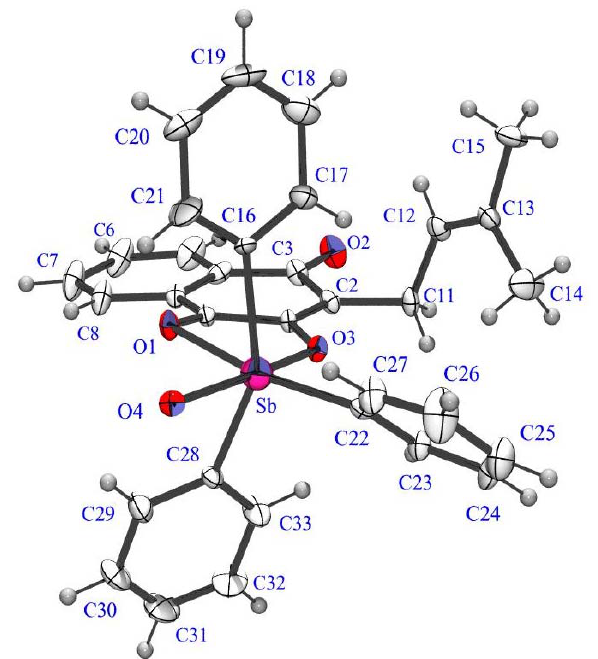
Figure 2. An ORTEP-3 projection of compound 2 showing the atom-numbering and displacement ellipsoids at the 30% probability